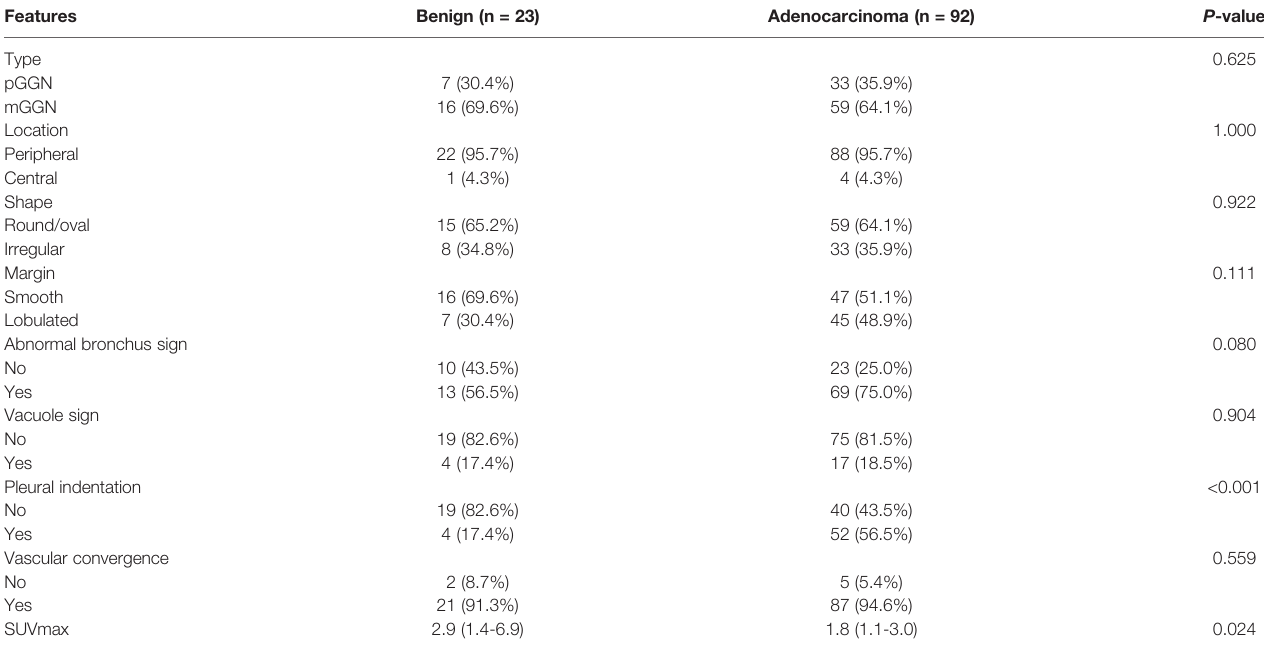
TABLE 2 | Comparison of CT semantic features and SUVmax of GGNs between benign group and adenocarcinoma group after PSM. Features